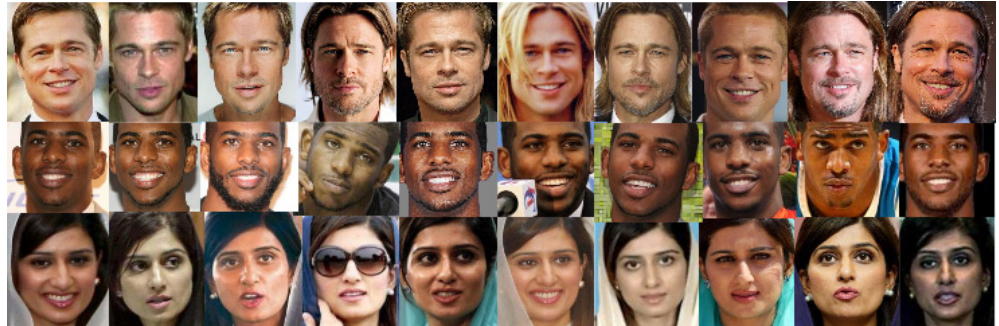
Figure 5. Example face images from the CFP Face Database.